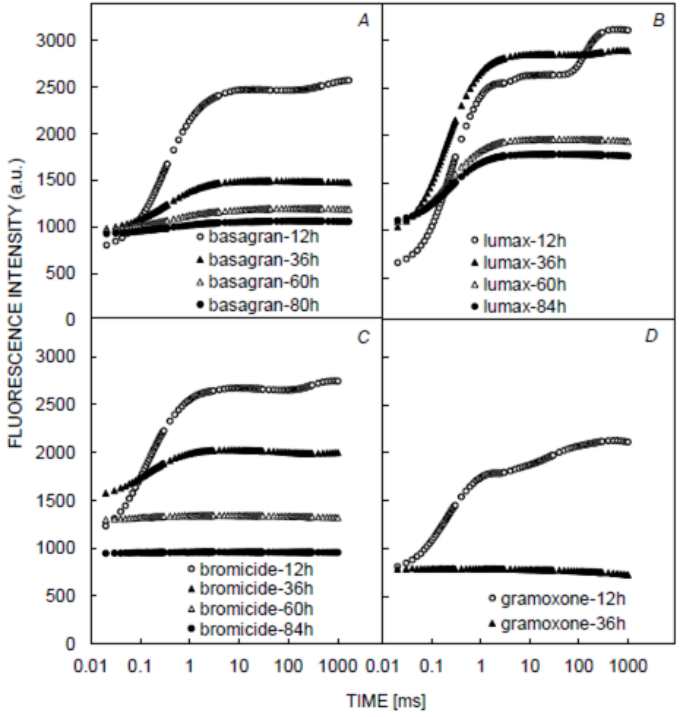
Figure 4. Effect of different herbicides on the shape of OJIP transients. Figures shows the effect of Basagran ( A ) , Bromicide ( B ) , Lumax ( C ), and Gramoxone ( D ) on the shape of OJIP curve.